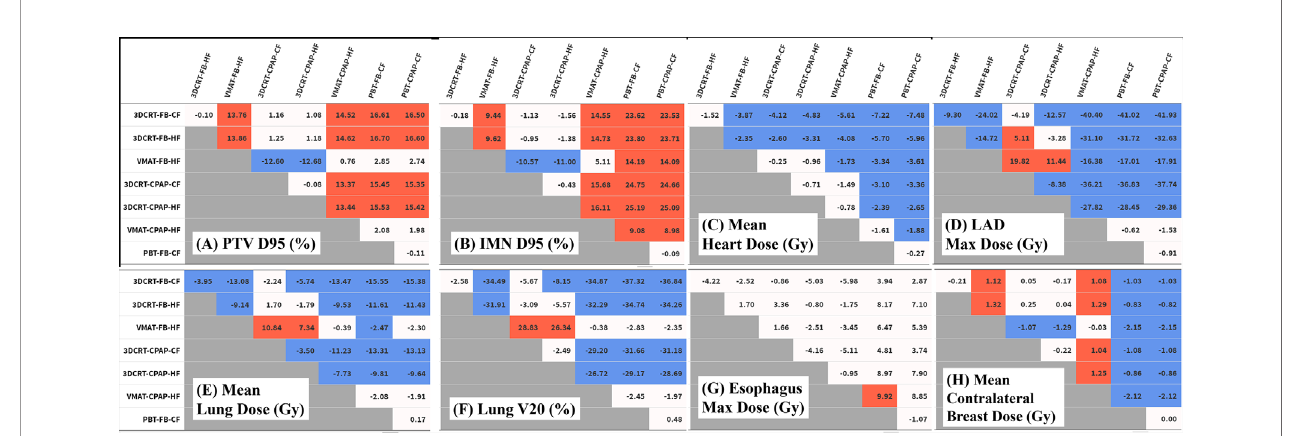
FIGURE 3 | Differences in dose distribution values. Each table represents the difference between techniques in the values of (A) PTV D95 (%), (B) IMN D95 (%), (C) mean heart dose (Gy), (D) LAD maximum dose (Gy), (E) mean lung dose (Gy), (F) lung V20 (%), (G) esophagus V20 (%), and (H) mean contralateral breast dose (Gy). Numeric values represent the difference of the value for the technique in the column from the technique in the row. Red cells indicate signi fi cant positive differences and blue cells indicate signi fi cant negative differences. IMN, internal mammary lymph nodes; LAD, left anterior descending artery; PTV, planning target